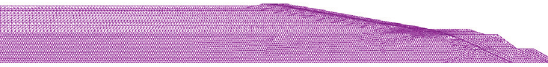
Figure 6: Finite element mesh of dam